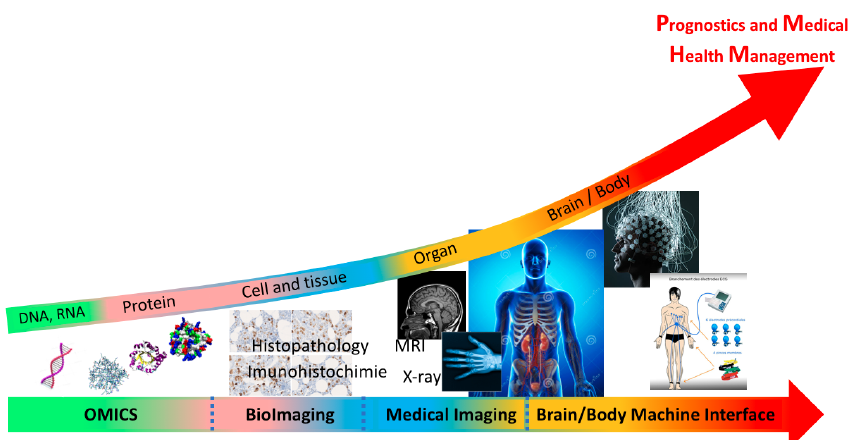
Figure 2. The different levels of the biomedical applications associated to each biomedical sub-field.